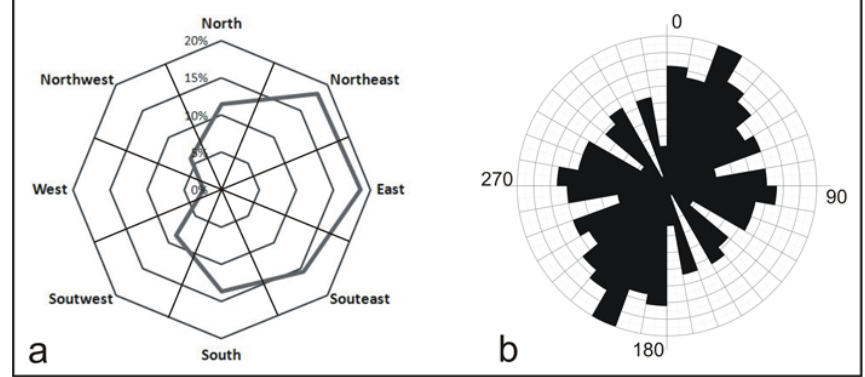
Fig. 8. (a) frequency distribution of the slope aspect within the whole study area: the highest value is for east-dipping slope; relative maxima are also for northeast- and south-facing slopes. (b) frequency distribution of the direction of the stream segments for the four considered catchments; note the peaks at SSW–NNE and at WNW–ESE directions.